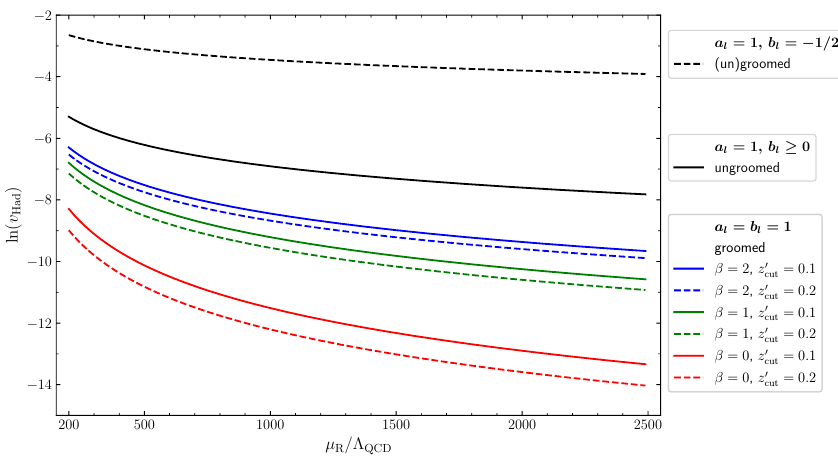
Figure 4 . Observable value v Had where to expect dominance of non-perturbative corrections, i.e. hadronisation effects, as a function of the dimensionless quantity µ R / Λ QCD . Results are given for different combinations of C AESAR parameters. For the case a l = b l = 1 , relevant for example for the thrust observable, we present results for different grooming parameter